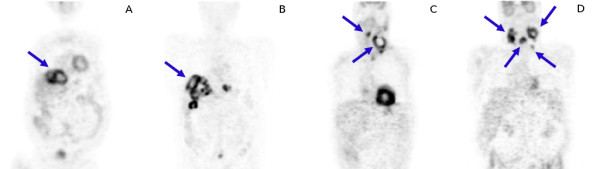
Representative coronal slices for two patients with liver metastases of a colorectal carcinoma (A, B) and for two patients with head and neck cancer (C, D).